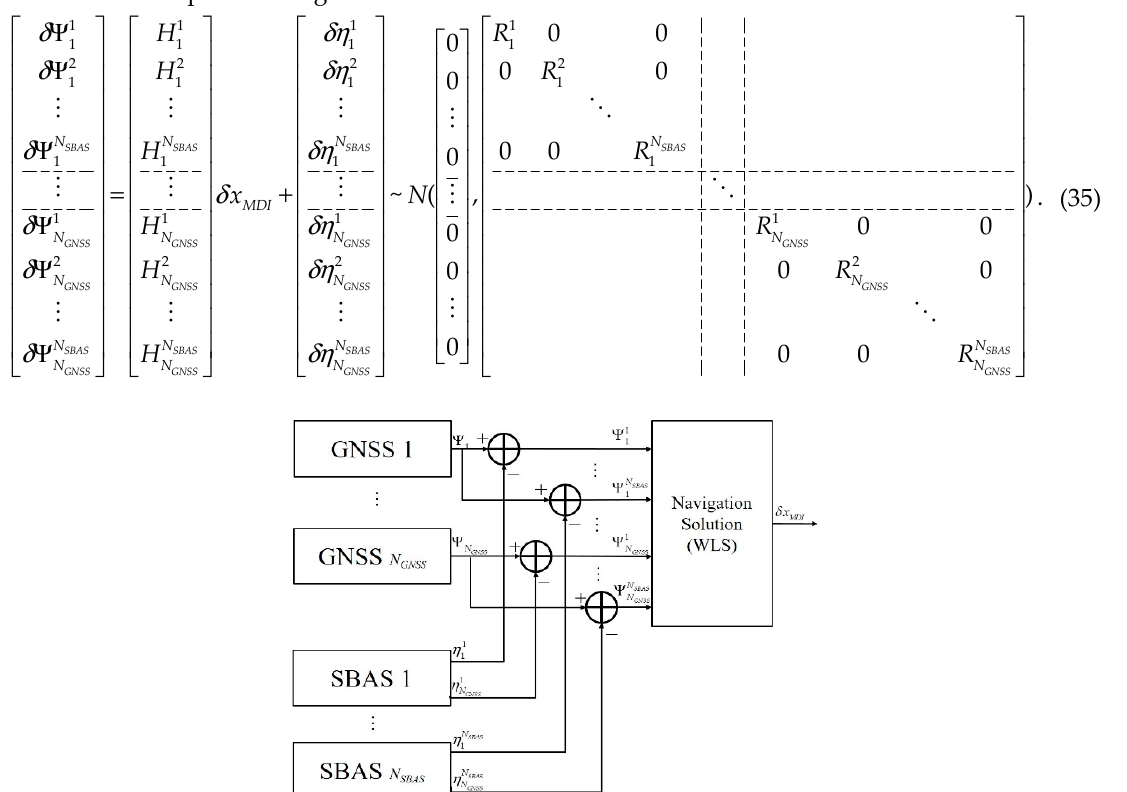
Figure 6. MDI for multi-GNSS augmented with multi-SBAS.